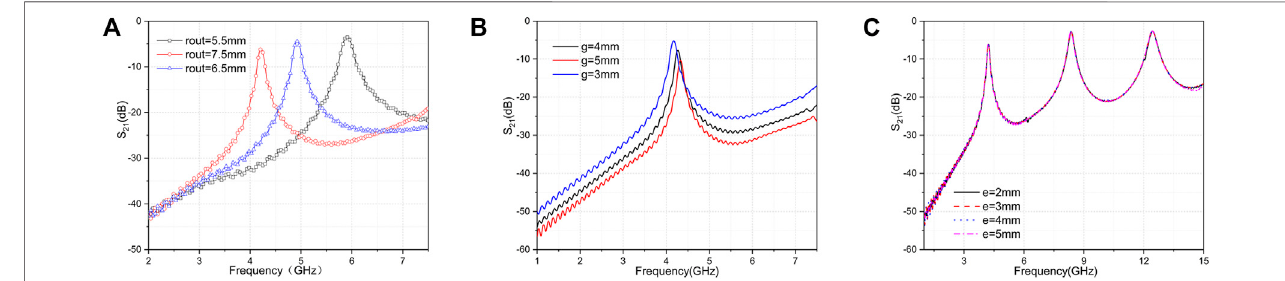
FIGURE4 |(A) Analysisofthe radius parameter r out ofthe SRRouter ring. (B) Parameter analysis ofthe SRRring opening spacing g. (C) Parameter analysis ofthe SRR ring opening spacing e .